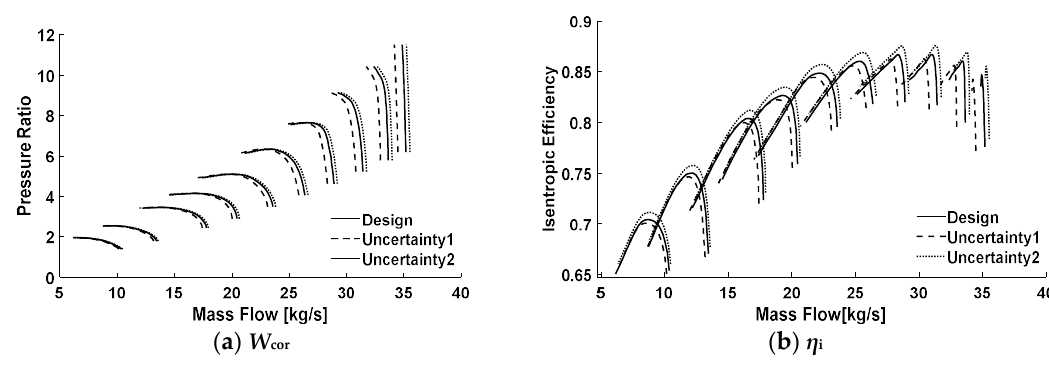
Figure 6. The characteristic map of uncertainty compressor performance.